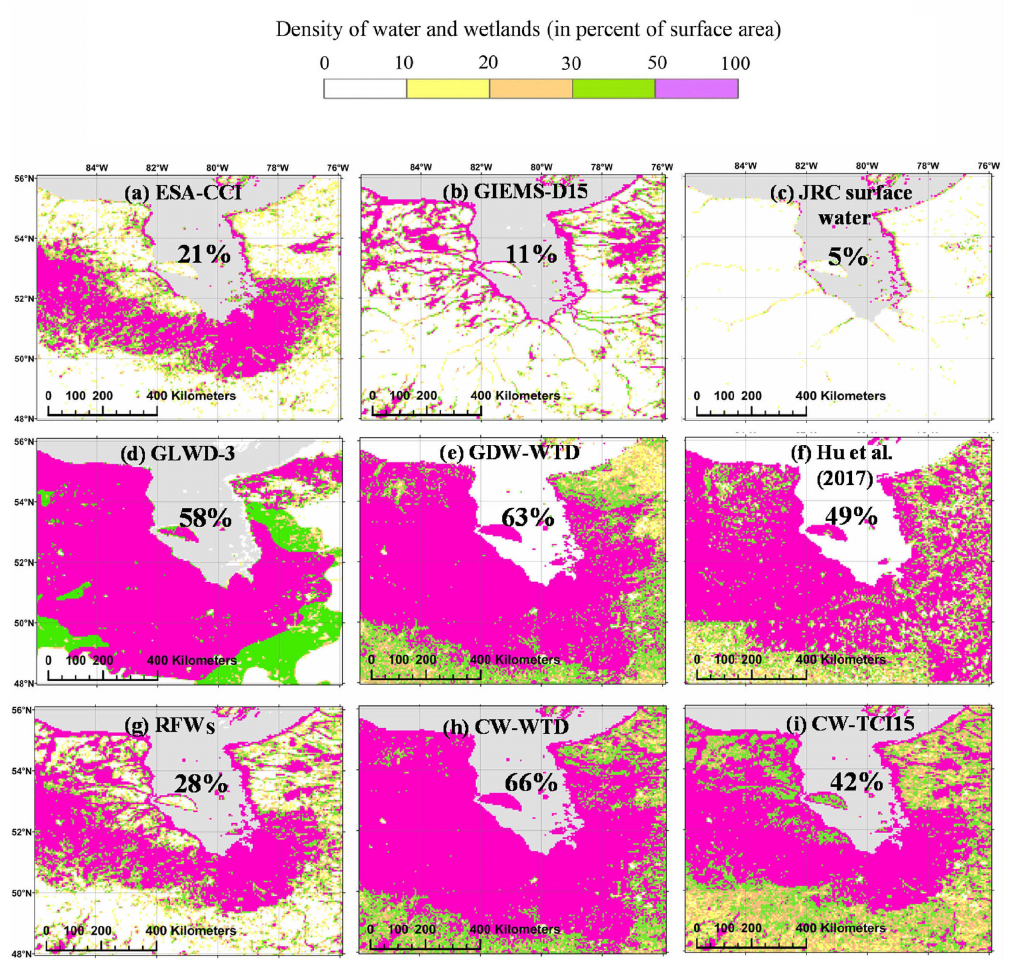
Figure 8. Maps of the Hudson Bay Lowlands wetlands according to different water and wetland datasets: (a–c) components of RFW, (d– f) evaluation datasets and (g–i) datasets generated in this study. The panels also give the mean areal wetland fraction of each dataset in the study area (using the mean fraction of each fractional wetland class of GLWD-3; cf. Sect. 2.5.1). The bounds of the study area are 48–56 ◦ N, 76–86 ◦